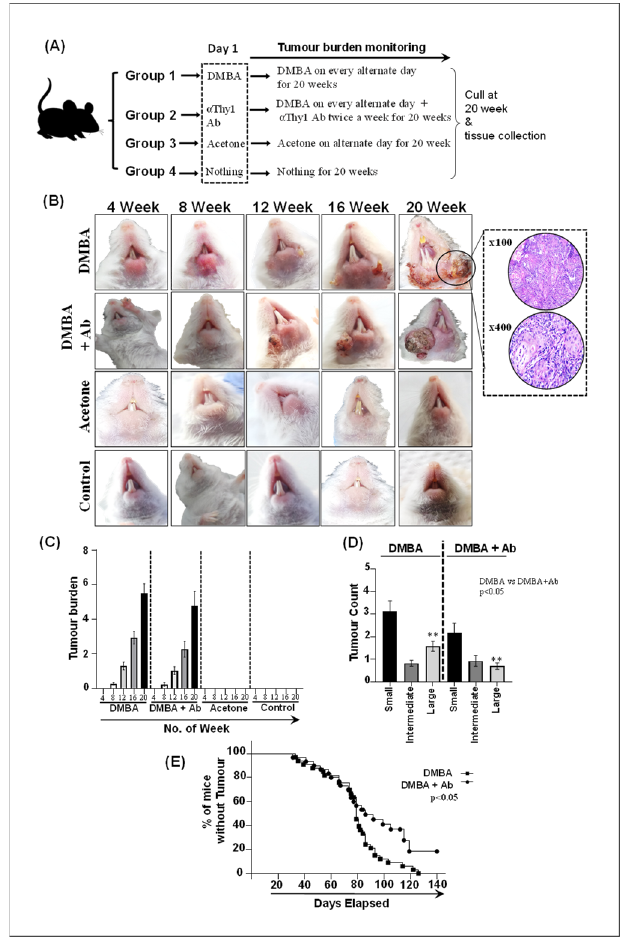
Figure 4. Representative images of murine experiment showing tumor burden, tumor size, and the percentage of mice with tumors. ( A ) Mice were divided into groups as follows: the DMBA group (n = 33), the DMBA+Ab group (n = 30), the acetone group (n = 5), and the control group (n = 5). Mice in the DMBA and DMBA+Ab groups were topically brushed with DMBA on the lower lip every other day for 20 weeks. Mice in DMBA+Ab also received intraperitoneal injections of the antiThy1 antibody (300 μ L) twice a week for 20 weeks. Mice in the acetone group were brushed with acetone on the lower lip every other day for 20 weeks, while mice in the control group received nothing. ( B ) Tumor burden was monitored at 4, 8, 12, 16, and 20 weeks. Mice in the DMBA and DMBA+Ab groups developed tumors that were histopathologically confirmed as oral squamous cell carcinoma. Mice in acetone and control groups did not develop tumors. ( C ) Tumor burden was reduced in DMBA+Ab mice compared to DMBA mice at weeks 8, 12, 16, and 20; however, the difference was not significant ( p > 0.05). ( D ) Small tumors were highest in numbers in both the DMBA and DMBA+Ab groups of mice. Large tumors in DMBA+Ab mice were significantly lower than in DMBA mice. ( E ) The Kaplan–Meier curve showed that at day 140 (20 weeks), all mice (100%) in the DMBA group developed tumors, whereas in the DMBA+Ab group, 10 (33.33%) mice were tumor-free ( p < 0.05). ** p < 0.01